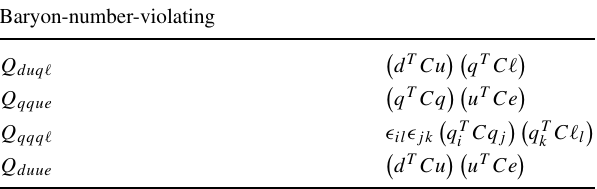
Table 7 SMEFT Baryon-number-violating